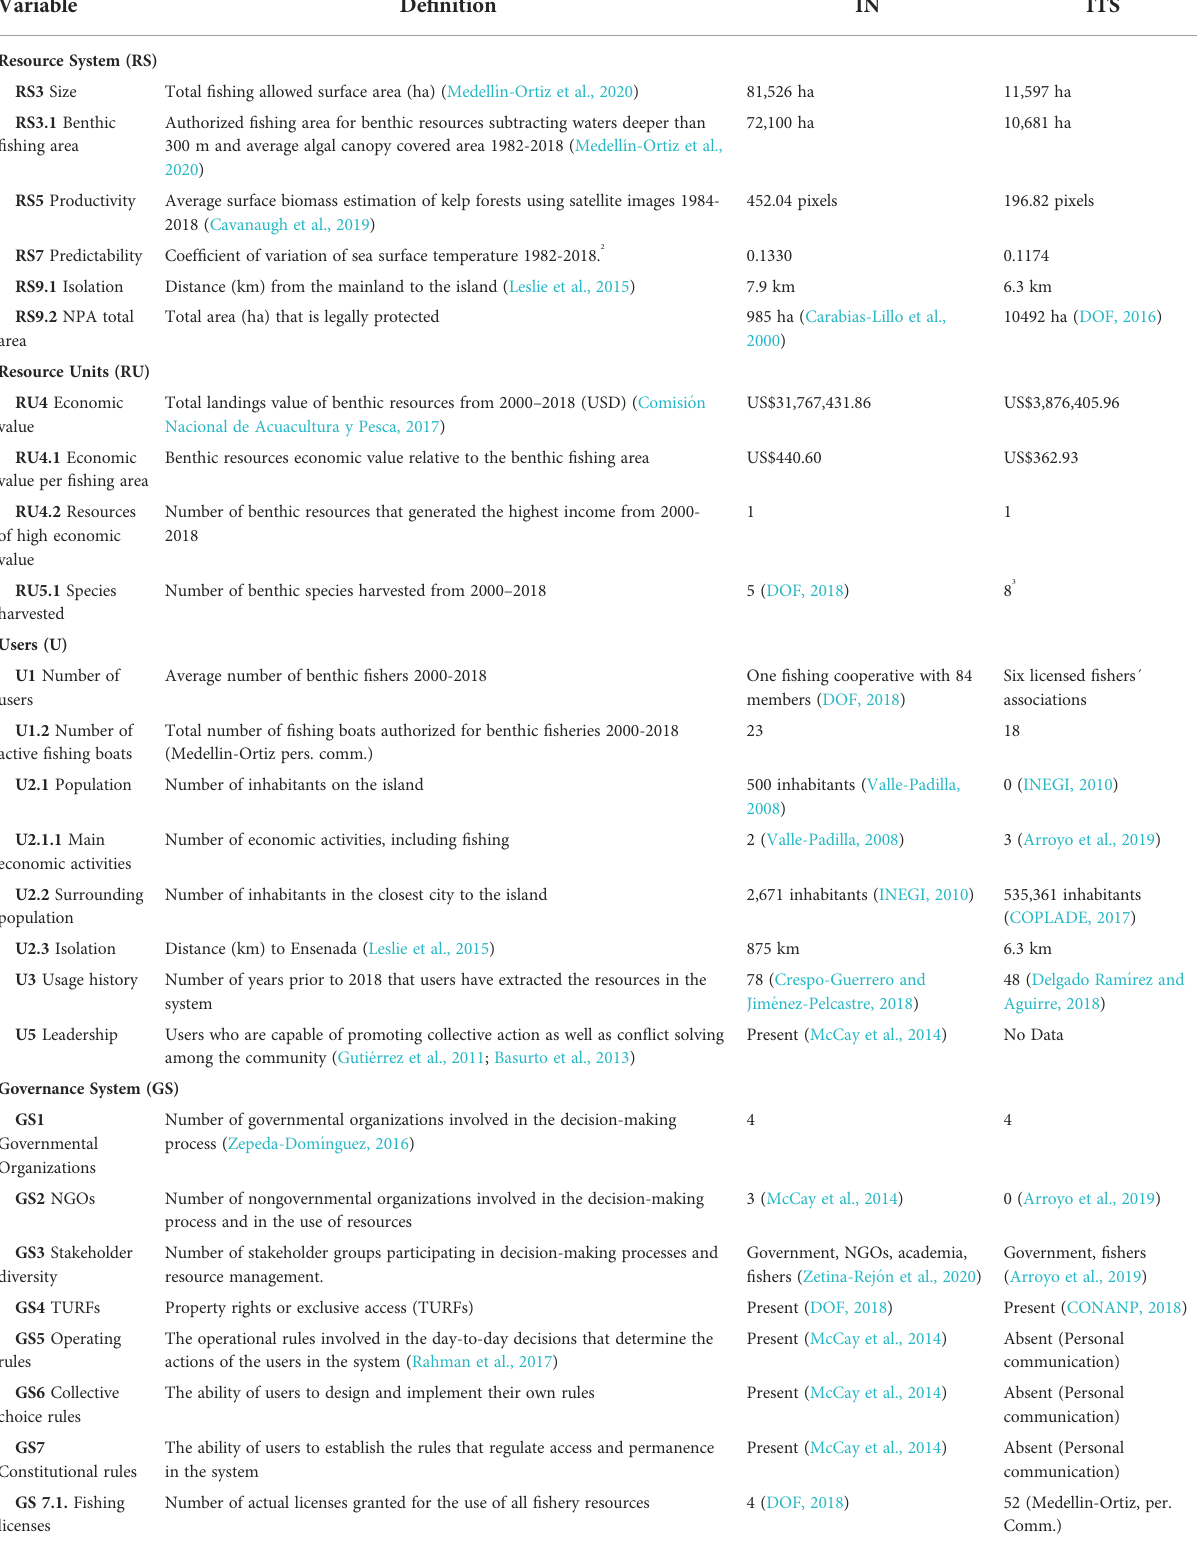
TABLE 1 List of variables used to compare Isla Natividad (IN) and Isla Todos Santos (ITS) adapted from Ostrom (Ostrom, 2009). Variable De fi nition